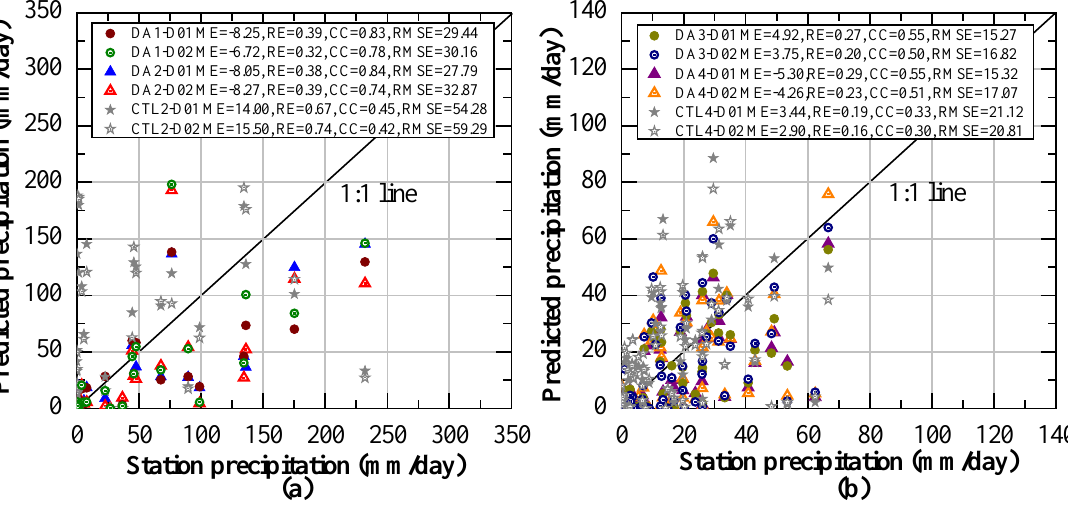
Figure 6. Scatter plots of daily precipitation (mm/day) observed by CMA meteorological stations and simulated by the CTL and DA experiments for rainfall events in August ( a ) and November ( b ) of 2015.